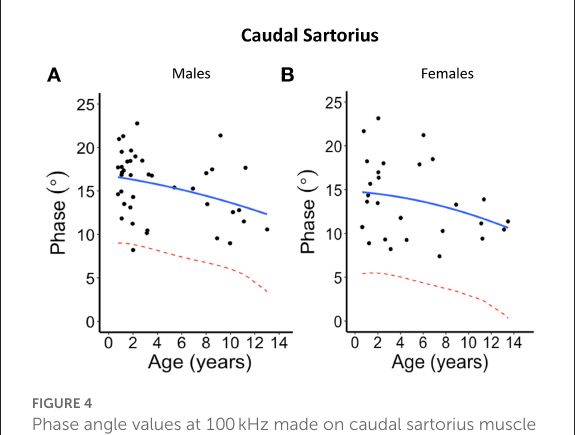
FIGURE4 Phase angle values at 100kHz made on caudal sartorius muscle for (A) males and (B) females. The blue solid line represents the normal fit generated from the second-degree polynomial regression through the log-transformed data while the red dotted lines represent the parallel curve that is the lower limit of normal based on the 95% prediction limit of the quadrative curve.